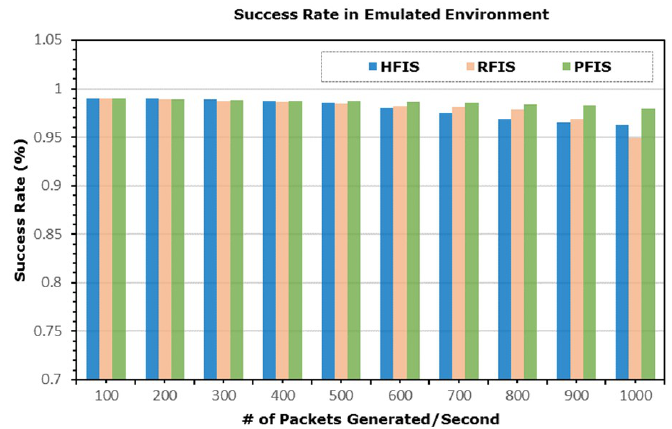
Figure 8. Latency in emulated environment. J. Sens. Actuator Netw. 2018 , 7 , x FOR PEER REVIEW